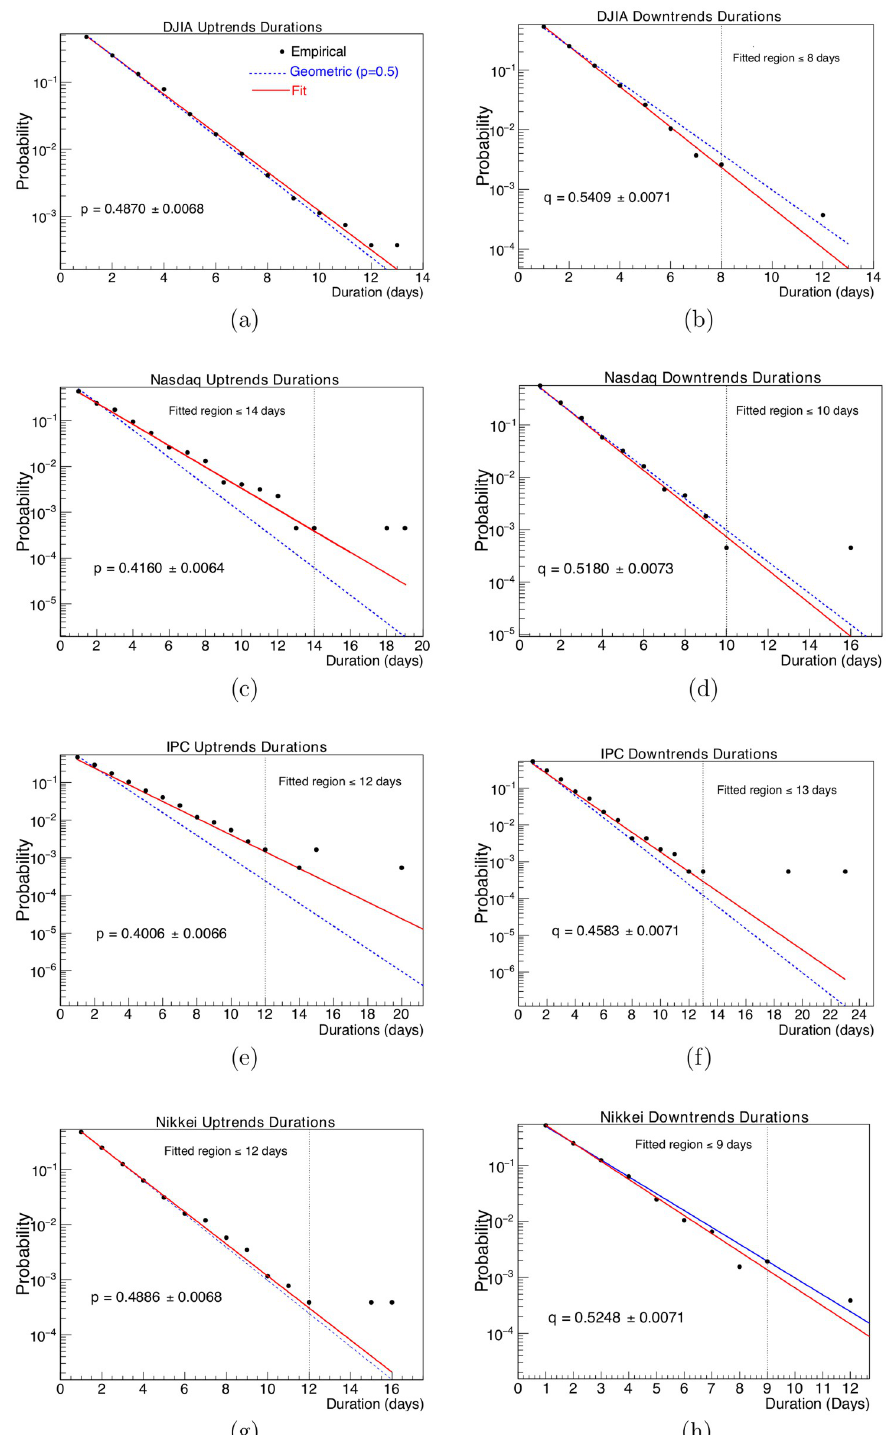
Fig 4. Subfigures 4(a), 4(c), 4(e) and 4(g) present the uptrends duration distributions and subfigures 4(b), 4(d), 4 (f) and 4(h) correspond to downtrends duration distributions. The solid lines are the fitted geometric distributions while the dotted lines are the expected geometric distributions ( p = 0.5). Parameters p and q are shown on each subfigure. Fit results are displayed in Table 7. Fitted regions are indicated in each plot by vertical dotted lines.